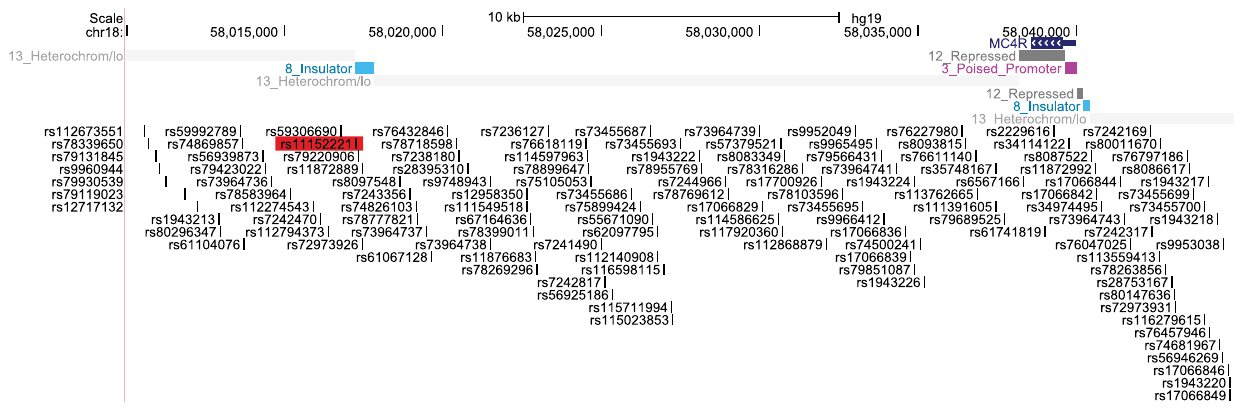
Figure 4. ENCODE-based transcriptional insulators near MC4R . Schematic depicting the genomic region (hg19 assembly) surrounding MC4R that contains rs11152221 (highlighted in red) and ENCODE-annotated insulators. Adapted from the UCSC Genome Browser, http://genome.ucsc.edu/ [51].